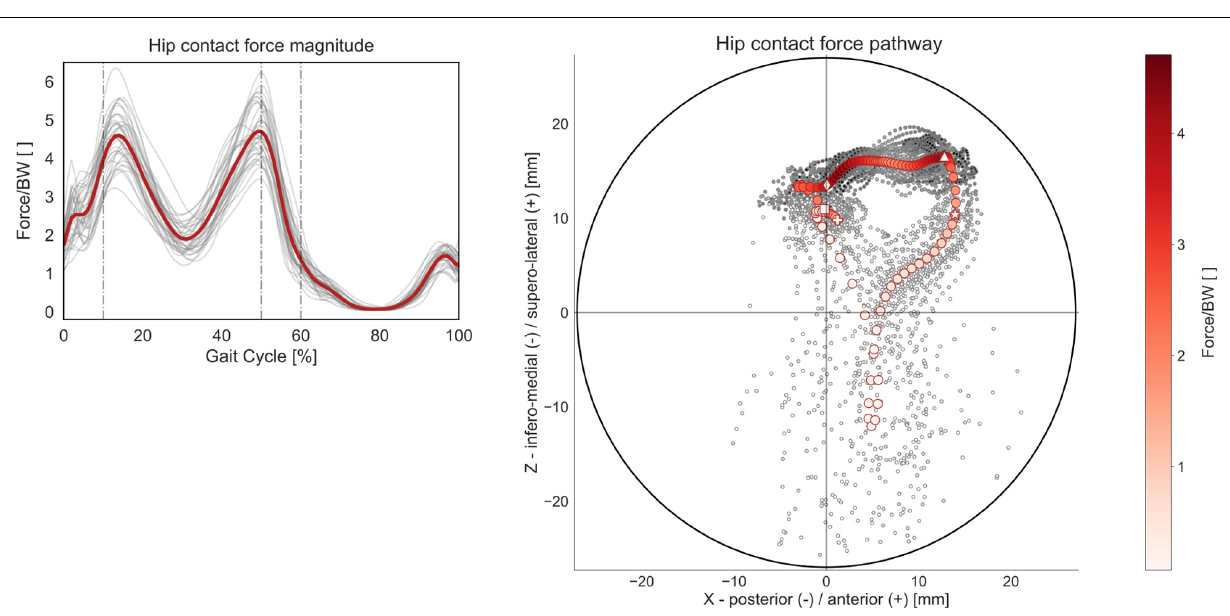
anterosuperior portion of the acetabulum (Beck et al.,